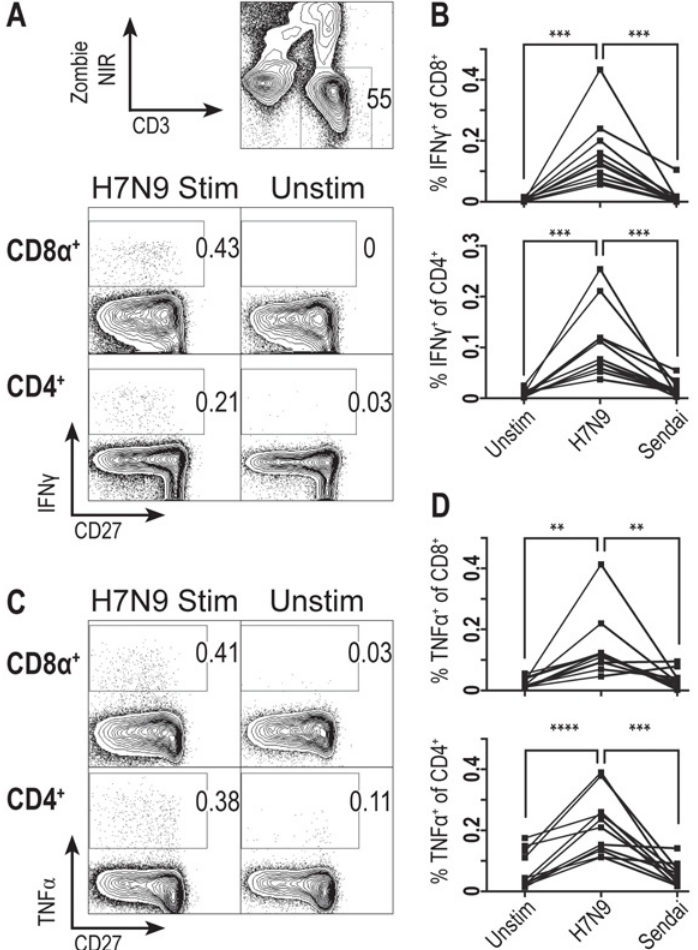
Fig 4. H7N9 is recognized by memory CD4 and CD8 T cells derived from humans with prior influenza virus exposure. (A) Representative IFN- γ expression frequency in human CD8 + and CD4 + cells either unstimulated or stimulated for 18 hours with whole inactivated H7N9 influenza virus. CD8 + and CD4 + cells gated on a ZombieNIR - /CD3 + population and derived from human PBMC samples purchased from Cellular Technology Limited. (B) IFN- γ frequency in live human CD8 + {top} and CD4 + {bottom} cells following 18 hours of stimulation with either whole inactivated H7N9 influenza virus, whole inactivated Sendai virus, or left unstimulated. N = 11; stimulations for individual patients are interconnected with lines. (C) Representative TNF- α expression frequency in human CD8 + and CD4 + cells either unstimulated or stimulated for 18 hours with whole inactivated H7N9 influenza virus, gated as described in A. (D) TNF- α frequency in live human CD8 + {top} and CD4 + {bottom} cells described in C. Statistics: One-tailed paired t tests used in 4B & D to compare H7N9 stimulated samples to either unstimulated or Sendai stimulated samples; p-values { ** < 0.01; *** < 0.001; **** < 0.0001}.